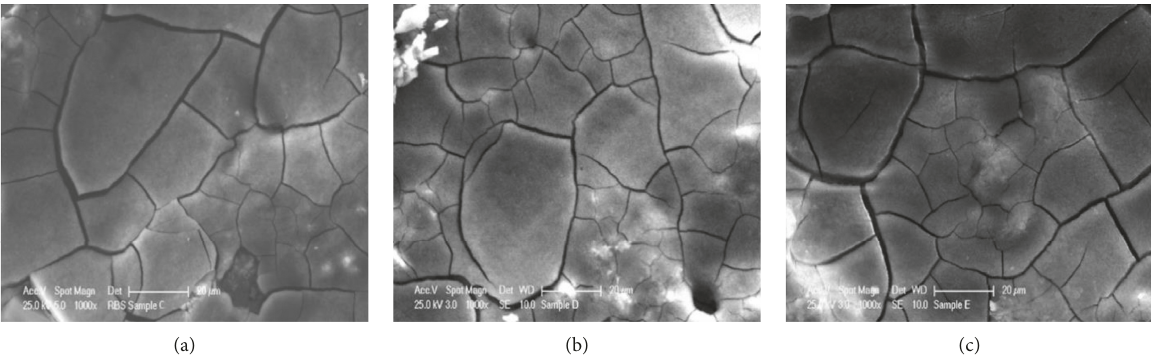
Figure 8: SEM images of Liapor coated with SiO (c) Calcined at 300 ° C and washed for 6hours.